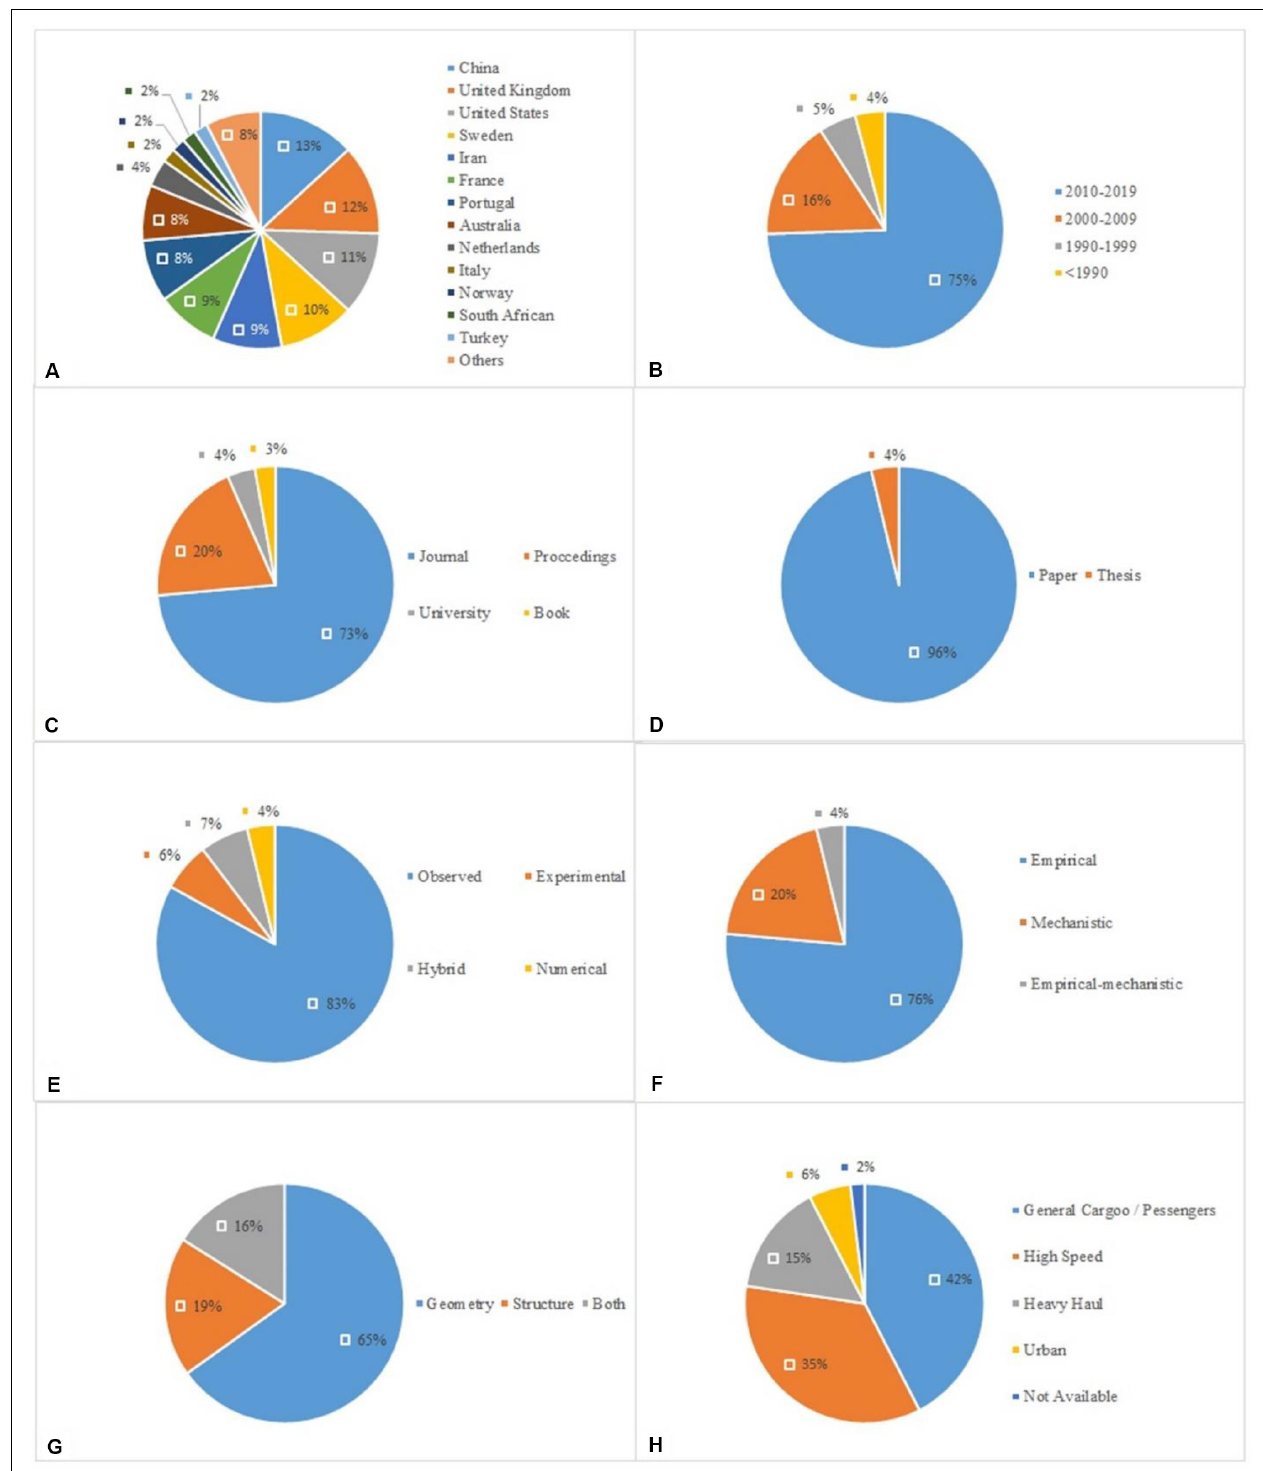
FIGURE 3 | Primary studies: (A) applied country, (B) published in, (C) sort of publication, (D) document type, (E) approach, (F) model, (G) element studied, and (H) railway system.